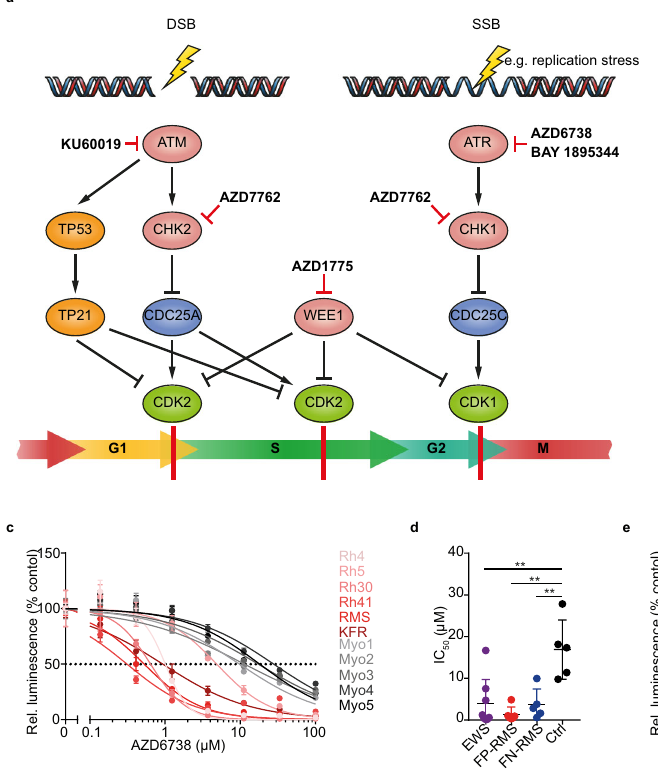
Fig. 1 | Fusion-positive ARMS cells are sensitive to pharmacological ATR inhi- bition. a Schematic of the DNA damage response pathway and small molecule inhibitor targeting proteins involved. DSB=Double Strand Break, SSB=Single Strand Break. b Heatmap showing sensitivity of ARMS (FP-RMS), Ewing sarcoma (EWS), ERMS (FN-RMS), and primary myoblast control cells (Ctrl) to the different DNA damage response inhibitors (blue indicates high sensitivity and red low sen- sitivityasde fi nedbytherankofIC 50 values). c Dose-responsecurvesofcellviability forFP-RMScelllinestreatedwiththeATRinhibitorAZD6738comparedtoprimary myoblasts( n =3). d IC 50 valuesforFP-RMS,EWS,FN-RMSandCtrlcellstreatedwith